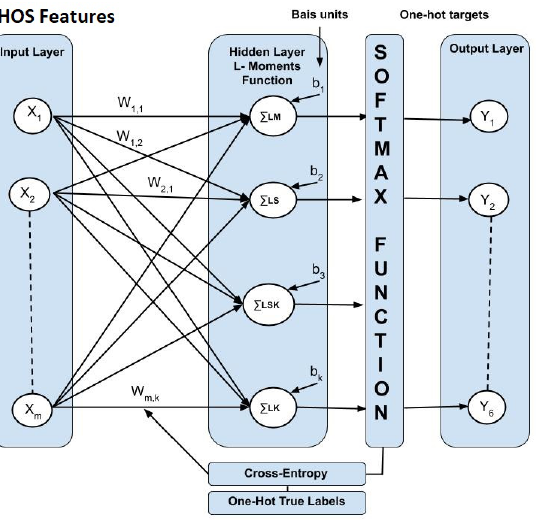
Figure 2. A MLP network architecture shows input layer, hidden layer and output